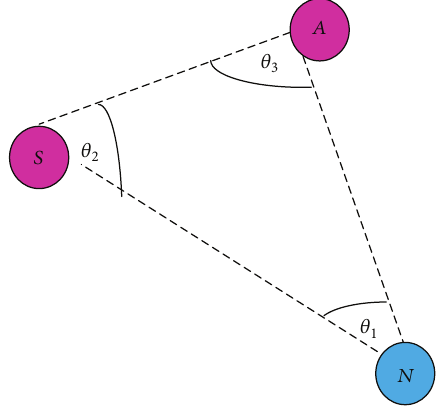
Figure 6: Interior